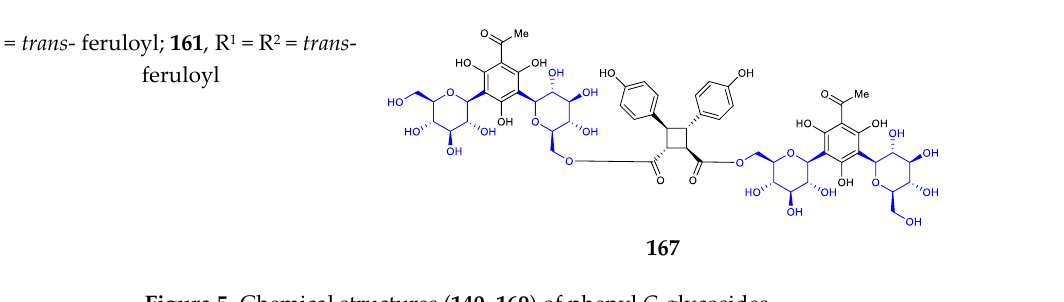
Figure 5. Chemical structures ( 140 – 169 ) of phenyl C -glycosides.